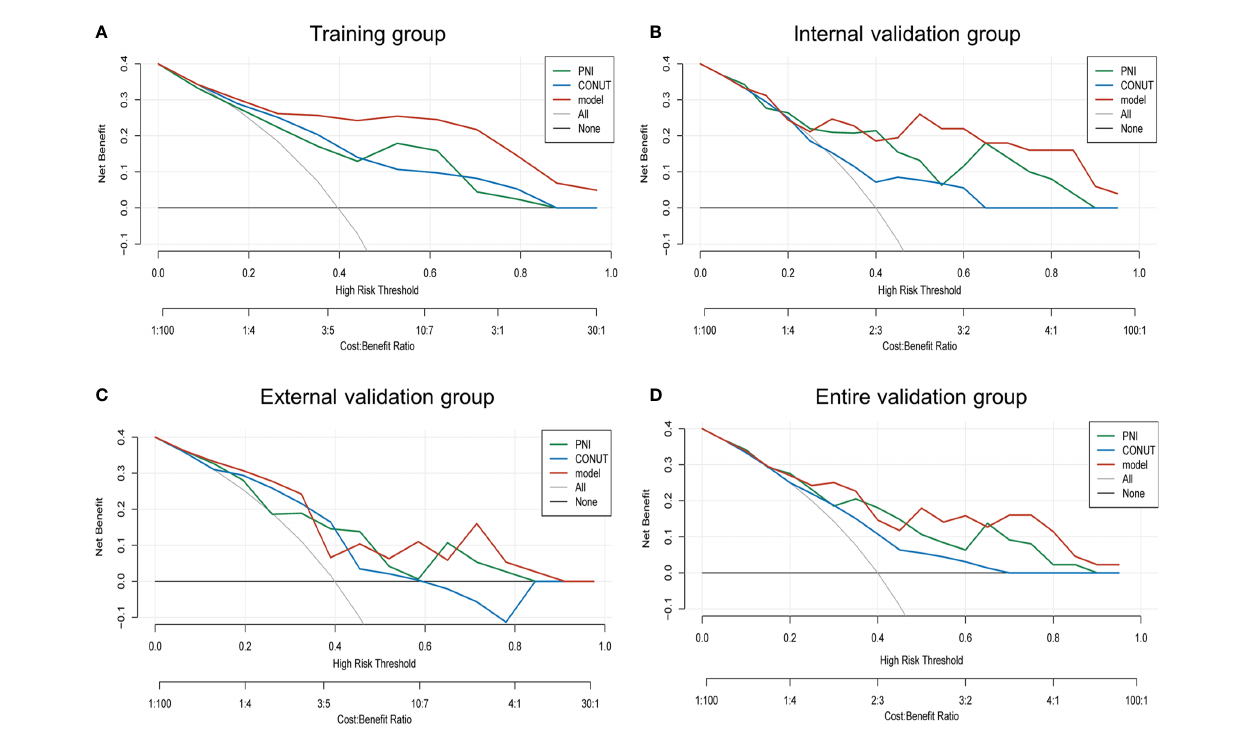
FIGURE 4 | Net bene fi t curves for predicting 2-year OS based on nomogram as compared with PNI and CONUT model in the training, internal validation, external validation and entire validation groups. (A) Net bene fi t curves based on nomogram as compared with PNI and CONUT model in the training group; (B) Net bene fi t curves based on nomogram as compared with PNI and CONUT model in the internal validation group; (C) Net bene fi t curves based on nomogram as compared with PNI and CONUT model in the external validation group; (D) Net bene fi t curves based on nomogram as compared with PNI and CONUT model in the entire validation